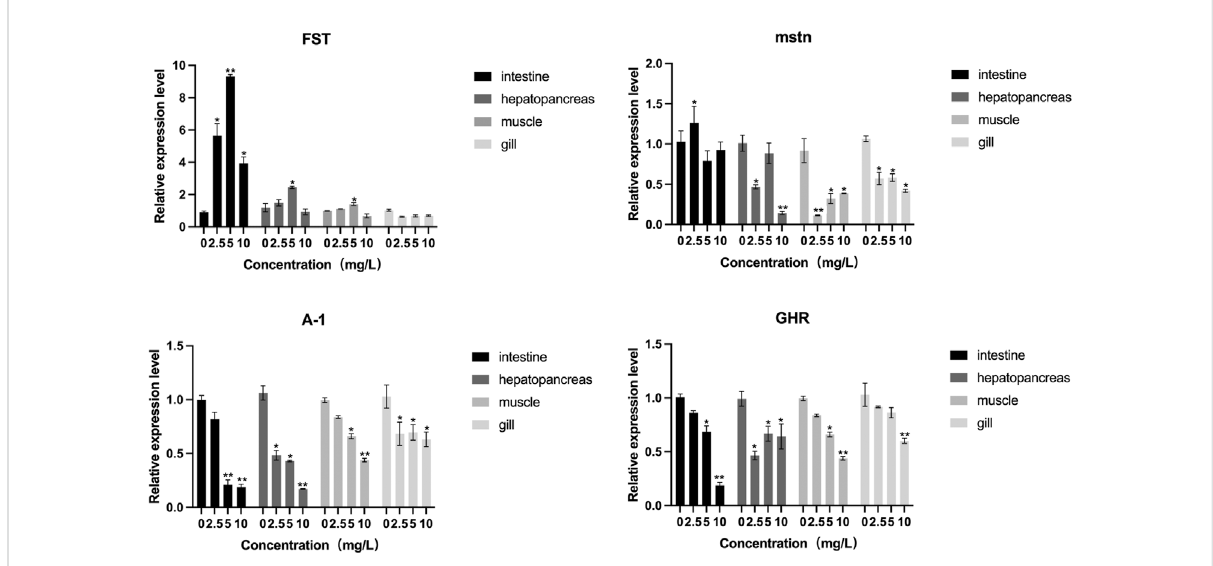
FIGURE 9 The effect of increasing concentrations of quercetin exposure on the relative expression of the FST, MSTN, A-I and GHR genes in the intestine, hepatopancreas, muscle and gill tissue of Odontobutis potamophila after 21 d. The bars indicate the Mean ± SD ( n = 3). Statistical signi fi cance was taken as *( p < 0.05) and **( p < 0.01) compared with the control.